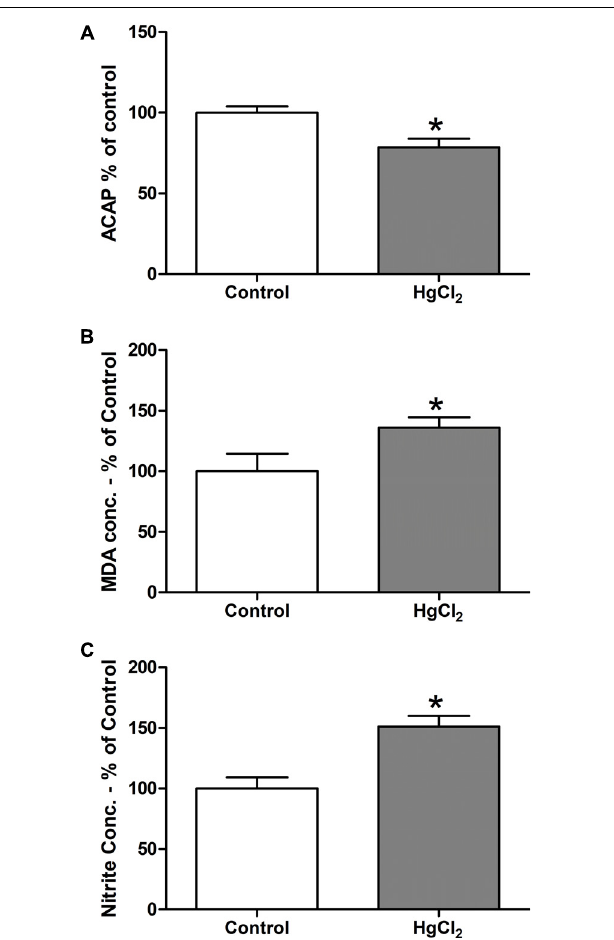
FIGURE 5 | Effects of chronic exposure to HgCl 2 on oxidative balance in the motor cortex of adult Wistar rats. The results are expressed as mean ± standard error of the (A) percentages of the fluorescence unit area difference of the generated curves of the same sample with and without ABAP in comparison to the control group; (B) percentage of malondialdehyde over control in mg, normalyzed per mg of protein; and (C) percentage of nitrite over control in mg, normalyzed per mg of protein. ∗ p < 0.05 compared to the control group (Student’s t -test).